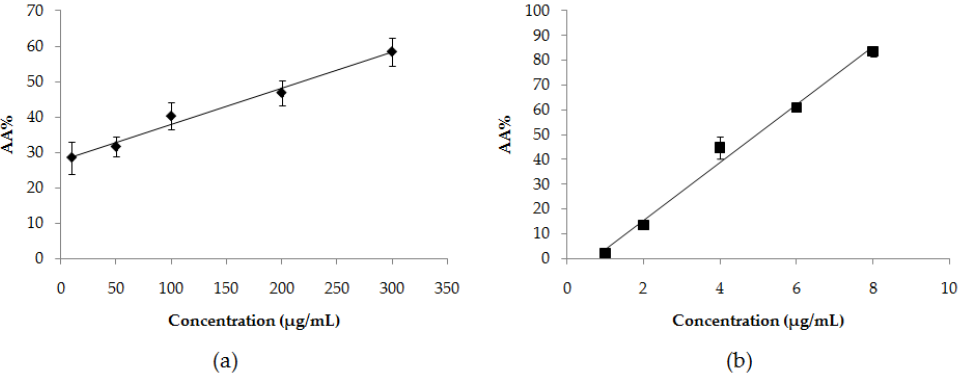
Figure 2. Antioxidant activity percentage (AA%) of ( a ) the herbal ball extract and ( b ) the positive control gallic acid at various concentrations.